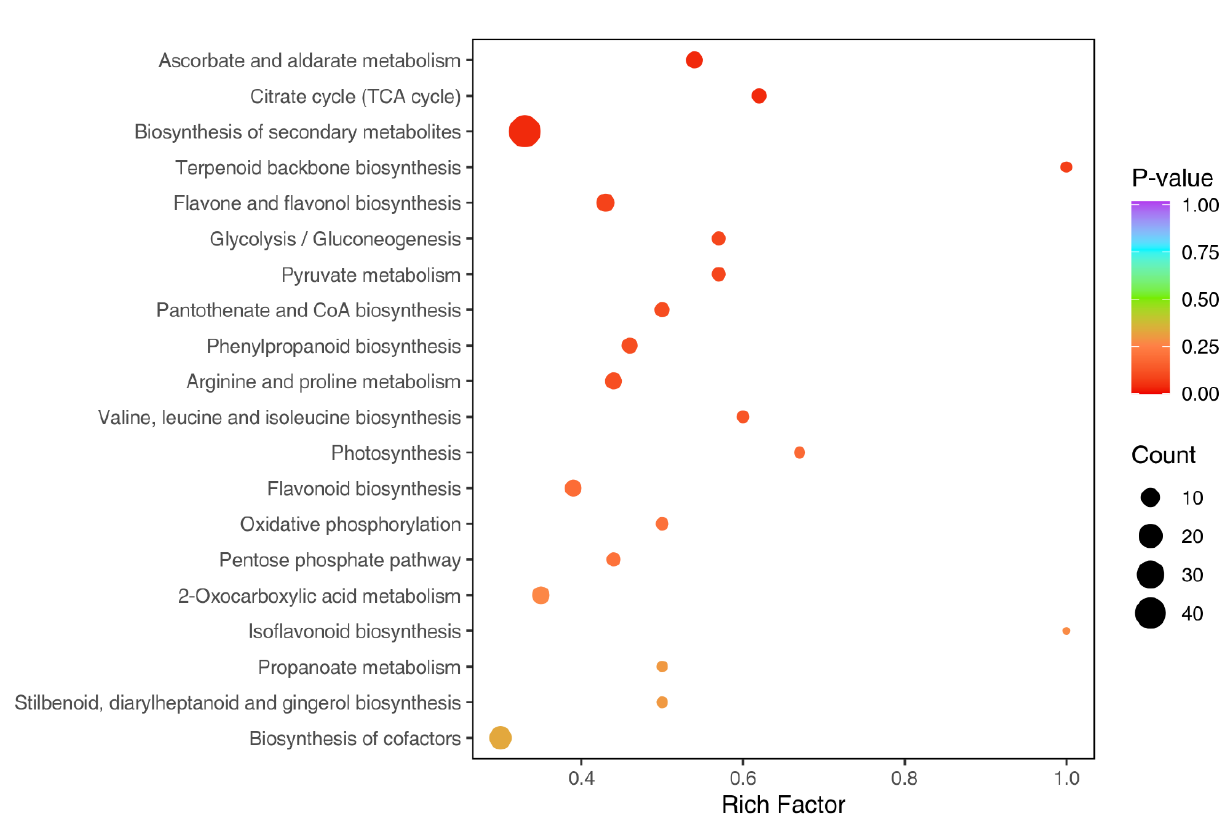
Figure 6. Rich factor (RF) values for the differentially expressed metabolites with annotated functions on the KEGG database. RF is the ratio of the number of differentially expressed metabolites in a pathway to the total number of metabolites annotated in the same pathway (RF for a pathway = no. of differentially expressed metabolites/total number of metabolites). Terpenoid backbone biosynthesis had significant enrichments, with an RF value of 1.